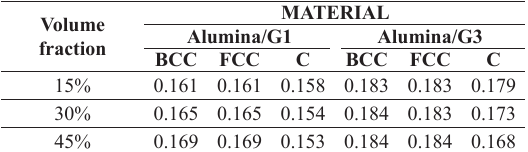
Table 2. Poisson coefficient values for Alumina/G1 and Alumina/G3 using a regular arrangement of inclusions. Volume